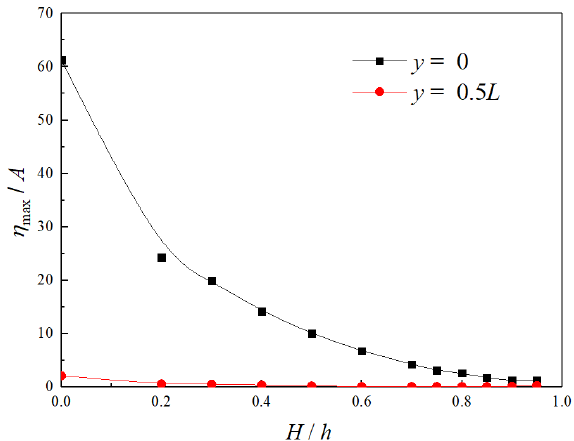
Figure 10. The maximum elevation of free surface at y = 0 and y = 0.5 L of sloshing in the tank under different baffle heights.